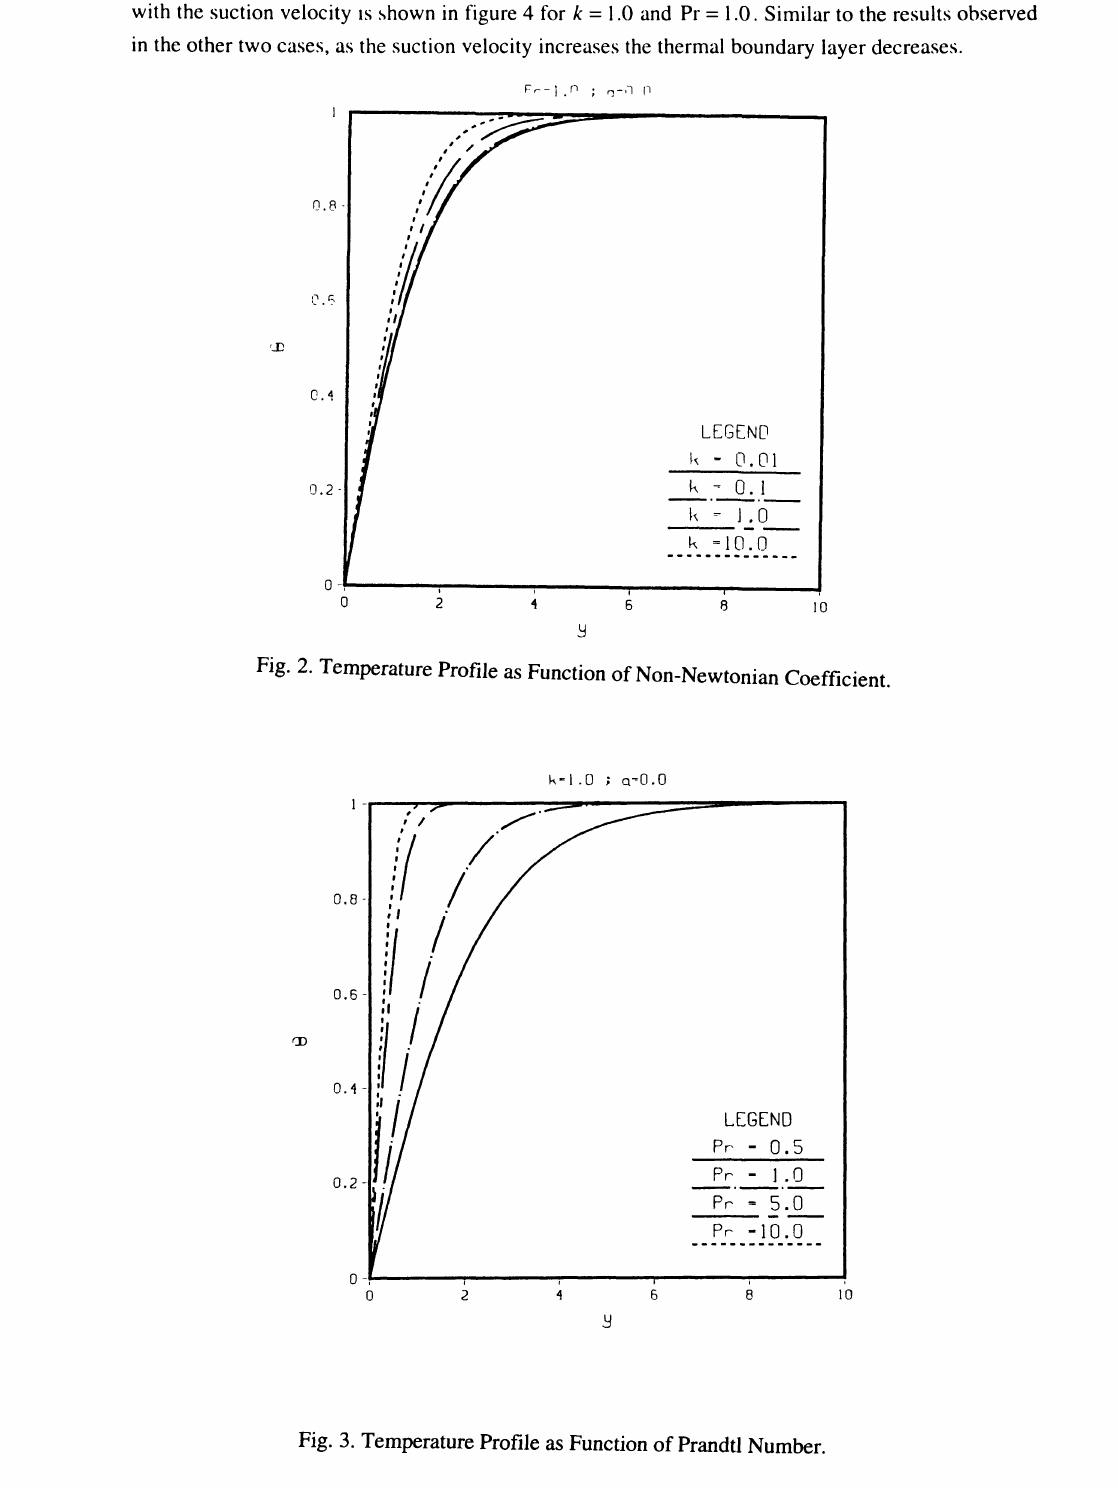
Fig. 3. Temperature Profile as Function of Prandtl